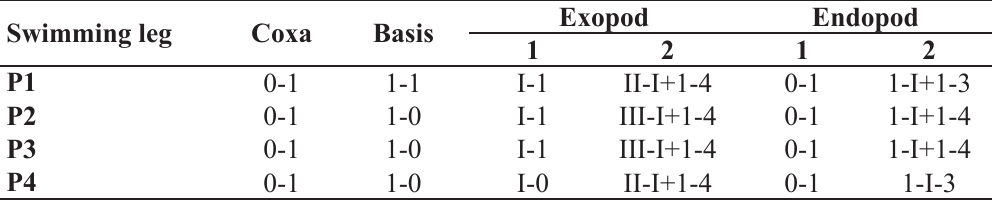
Table 1. Armature formula of P1–P4 in Metacyclops sakaeratensis sp. nov. and M. brancelji sp. nov. Roman numerals represent number of spines and Arabic numerals represent number of